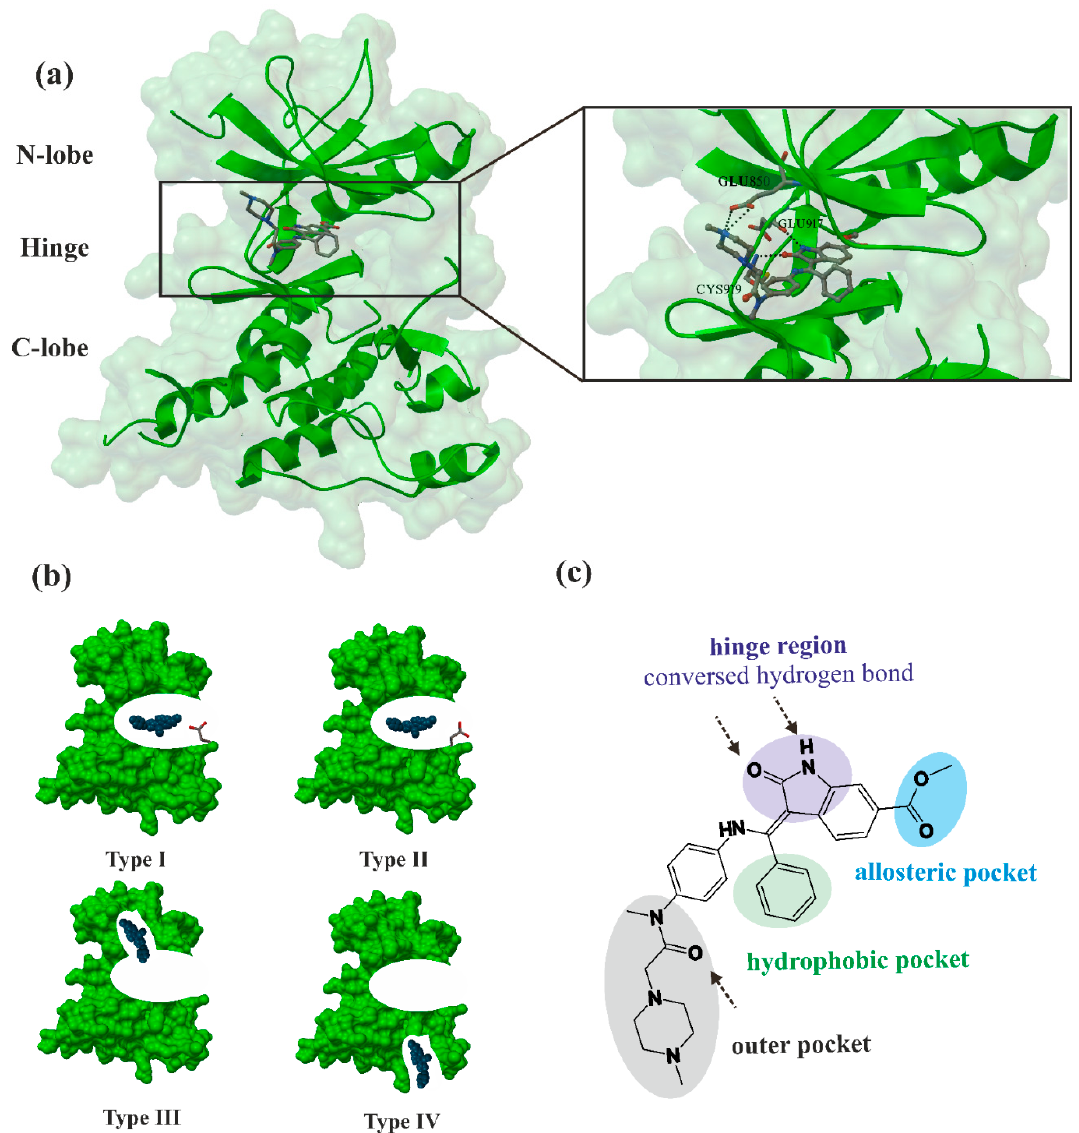
Figure 1. Transmembrane receptor RTK, different types of reversible inhibition and graphical representation of nintedanib RTK pharmacophore features. ( a ) X-ray structure of nintedanib bond in the active site of the VEGFR-2 crystal with the enlarged area showing the structural elements around the ligand-binding site (PDB ID: 3C7Q, 2.10 Å) [21]. The molecular mechanism of action of nintedanib consists of the competitive binding to the adenosine triphosphate (ATP) pocket. The result is inhibition of intracellular signaling vital for the proliferation, migration, and transformation of fibroblasts, which are fundamental to IPF [22]. ( b ) The literature-derived classification of reversible inhibitor types: where type I is binding to the active kinase hinge area (DFG-in) while type II is binding to the respective inactive area (DGF-out). Both inhibitor types compete directly with ATP by stabilizing enzymatically relevant kinase conformations. Inhibitors of type III and IV allosterically interact outside the hinge area (i.e., in its close vicinity or back) or activate remote residues in the kinase domain [14,23]. ( c ) Pharmacophore points defined according to the literature for nintedanib structure [1,14].